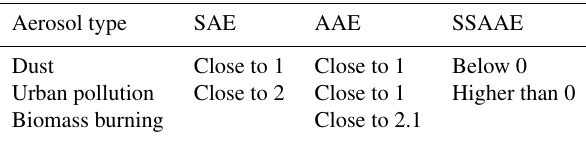
Table 1. Expected aerosol type and their optical properties for each cluster according season and atmospheric stability.